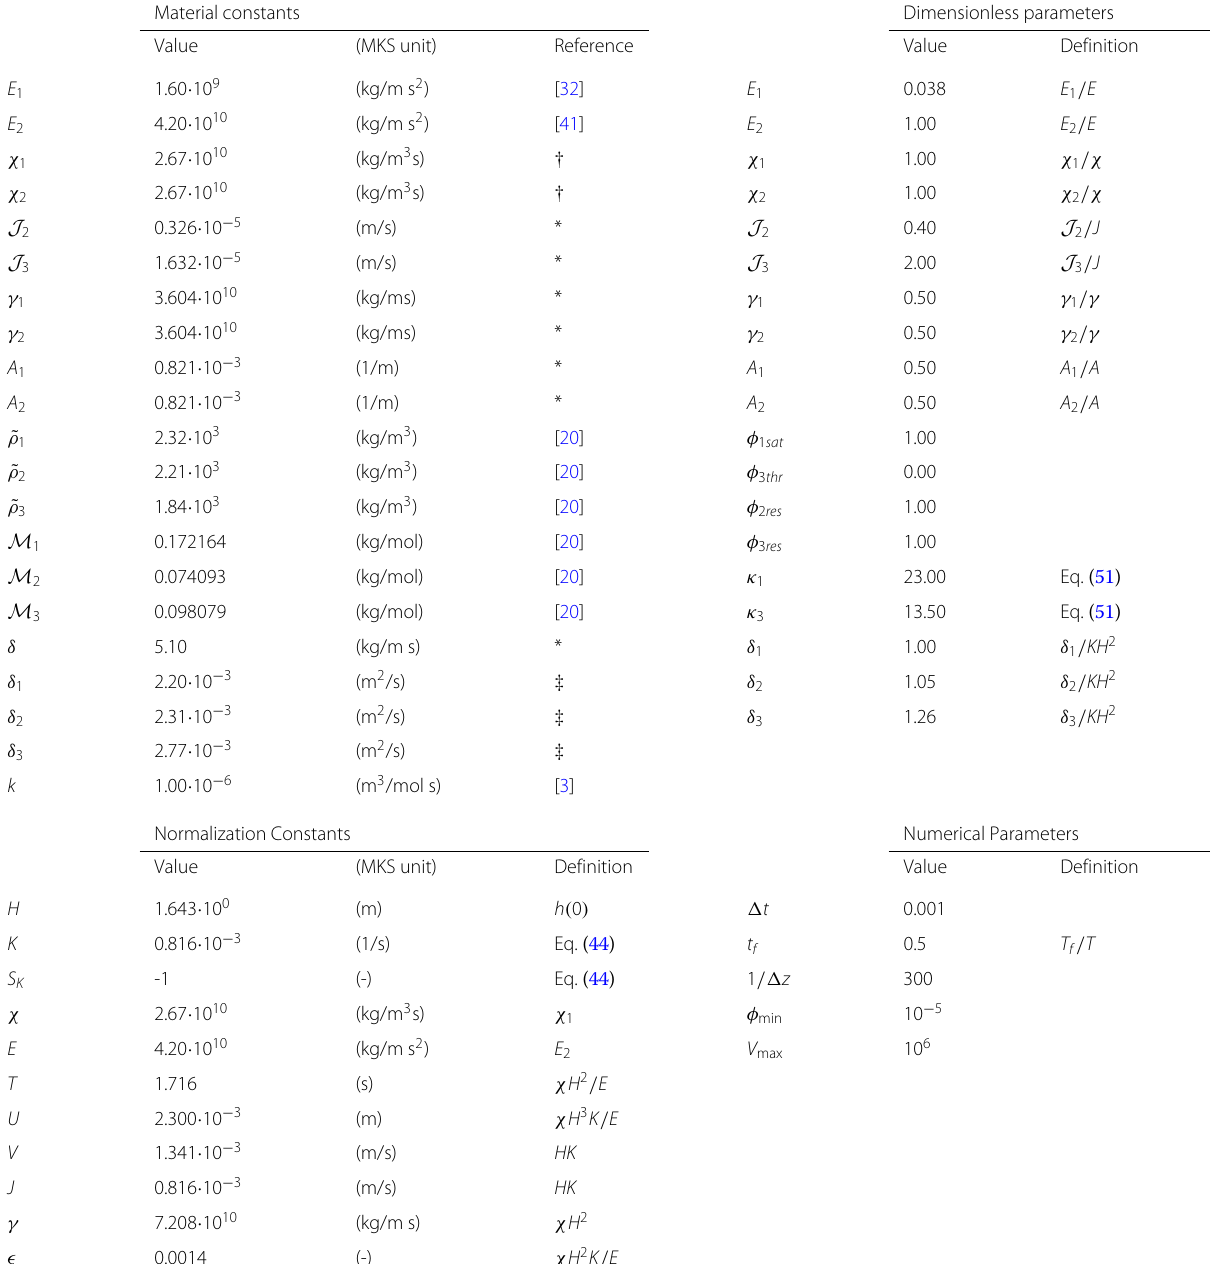
Table 1 Table with numerical values of material constants, normalization constants, dimensionless parameters, and numerical parameters Material constants Dimensionless parameters (MKS unit) Reference